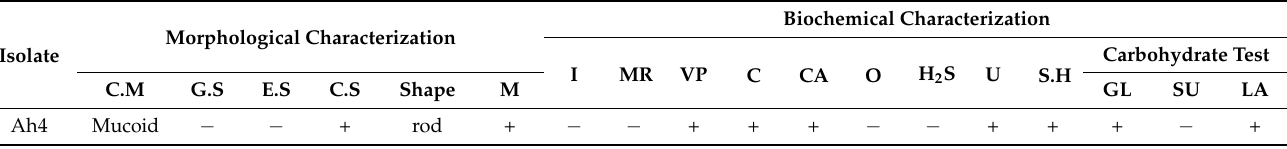
Table 3. Morphological, physiological, and biochemical characterization of isolate